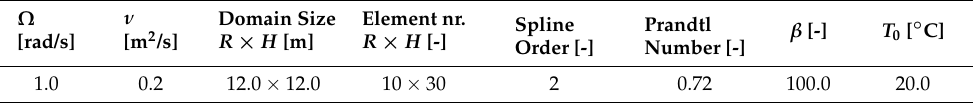
Table 4. Parameters used for the von Kármán rotating disk heat transfer